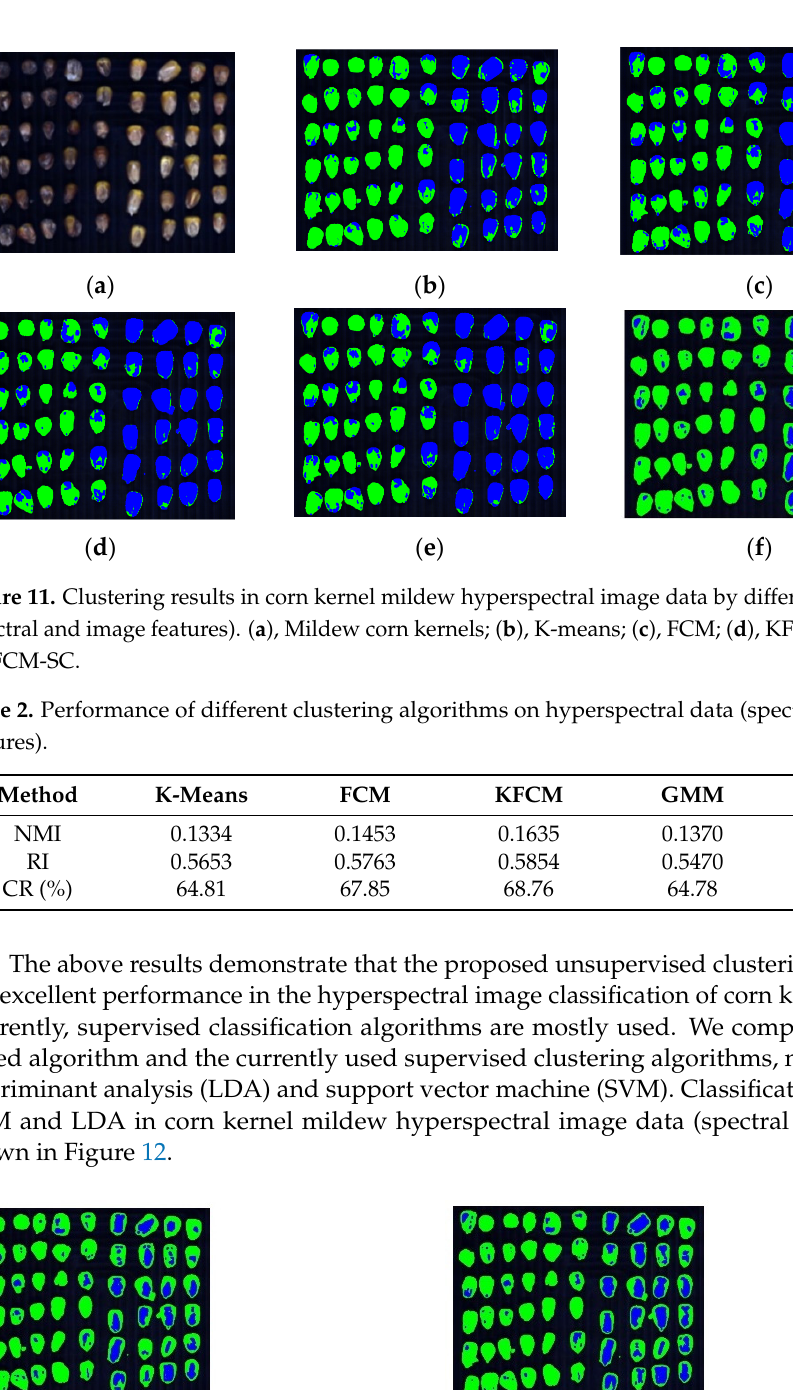
( f ) Figure 10. Clustering results in corn kernel mildew hyperspectral image data by different algo- rithms (spectral features). ( a ), Mildew corn kernels; ( b ), K-means; ( c ), FCM; ( d ), KFCM; ( e ), GMM; ( f ), FCM-SC. Table 1. Performance of different clustering algorithms on hyperspectral data (spectral features). Method